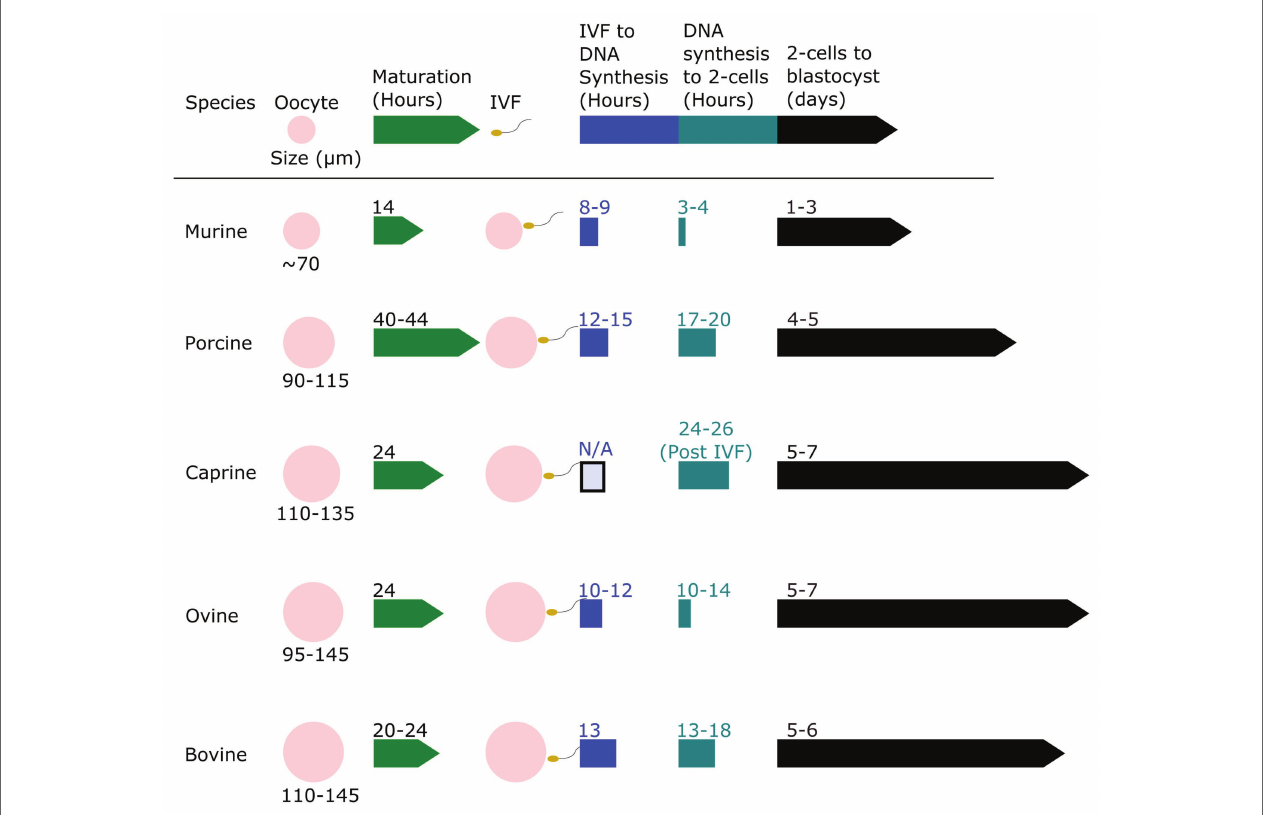
FIGURE 2 | Relative oocyte size and a timeline of embryo development for murine, porcine, caprine, ovine, and bovine zygotes. The oocyte size of murine, porcine, caprine, ovine, and bovine species are shown to scale and compared. The relative timeline of embryo development from the oocyte stage to blastocyst stage after in vitro fertilization (IVF) is shown. Data derived from Harlow and Quinn (1982), Motlik et al. (1984), Crosby et al. (1988), Papaioannou and Ebert (1988), Sakkas et al. (1989), Prather (1993), Campbell et al. (1994), Gardner et al. (1994), Laurincik et al. (1994), Fair et al. (1995, 1997), Rath et al. (1995), Serta et al. (1995), Bouniol-Baly et al. (1997), Otoi et al. (1997), Gómez et al. (1998), Wang et al. (1998, 2012), Anderson et al. (1999), Comizzoli et al. (2000), Raghu et al. (2002), Sanfins et al. (2003), Ciemerych and Sicinski (2005), Moon et al. (2005), Griffin et al. (2006), Ptak et al. (2006), Surjit et al. (2006), Zhou and Zhang (2006), Anguita et al. (2007), Chaves et al. (2010), Catalá et al. (2011), O’Hara et al. (2014), Paramio and Izquierdo (2014), Morohaku et al. (2016), Cadenas et al. (2017), Yoon et al. (2018), HosseinNia et al. (2019), McLean et al. (2020), and Owen et al.